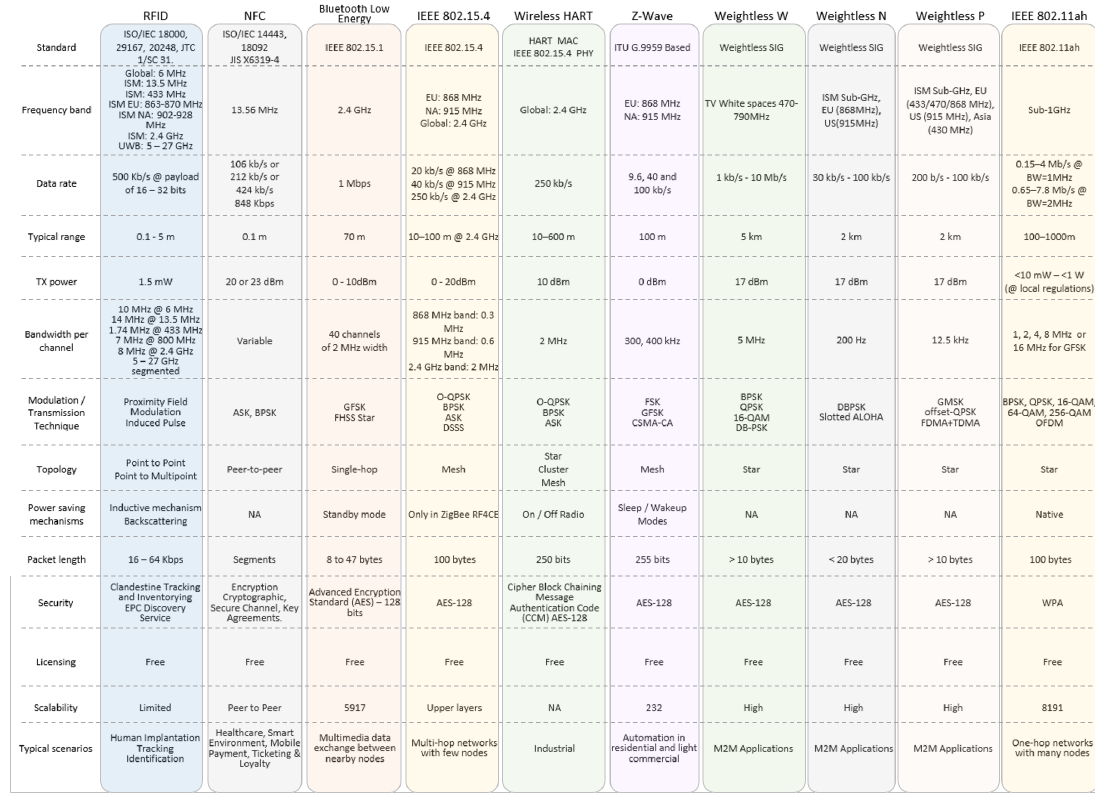
Figure 24. Comparison of the short range